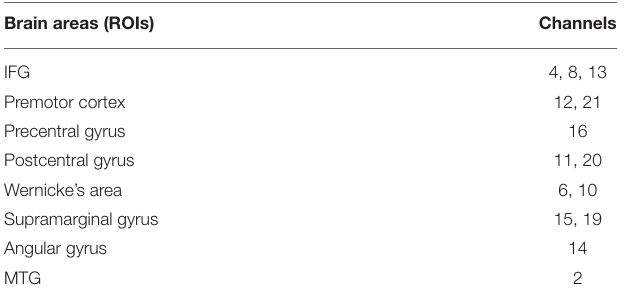
TABLE 1 | ROIs with assigned fNIRS channels (all on the left